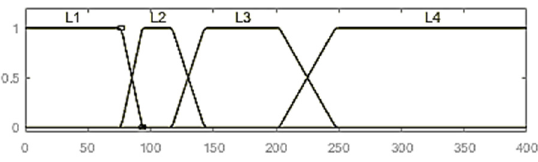
Figure 8. Input membership functions for DPM interpretation results. Figure 9. Input membership functions for H 2 .